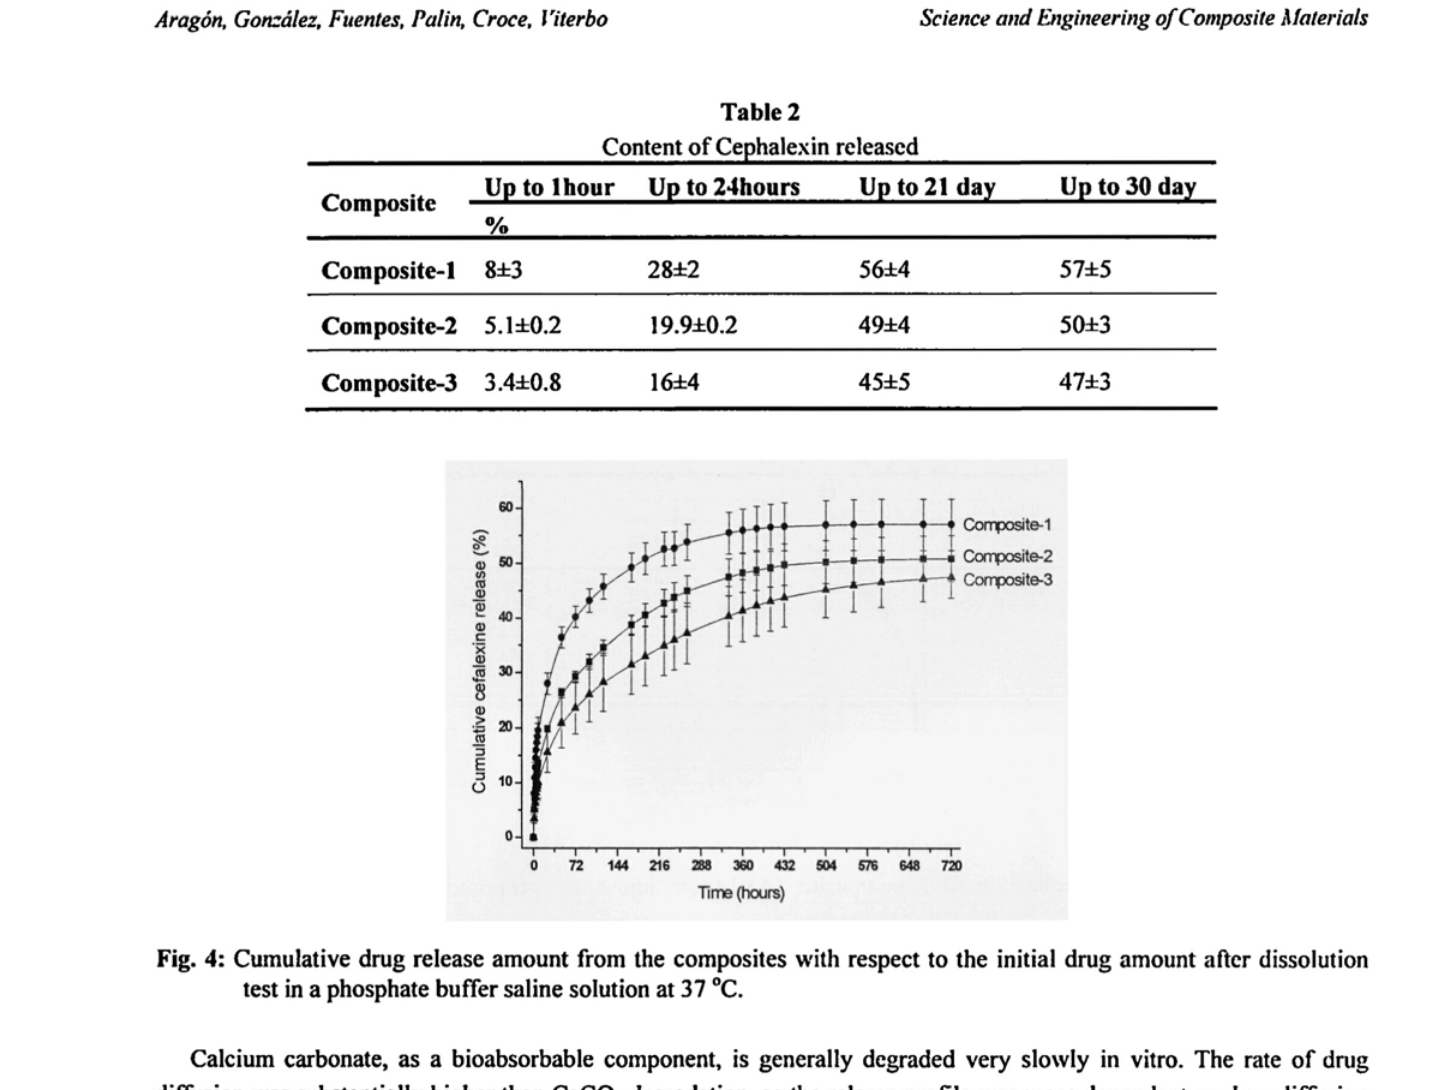
Fig. 4: Cumulative drug release amount from the composites with respect to the initial drug amount after dissolution test in a phosphate buffer saline solution at 37 °C.